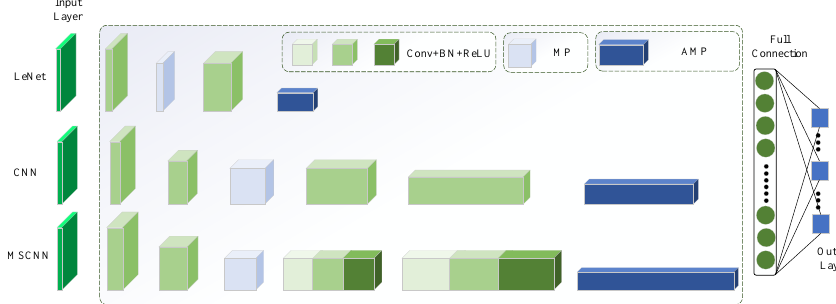
Figure 6. A brief architecture of LeNet, CNN, and MSCNN.